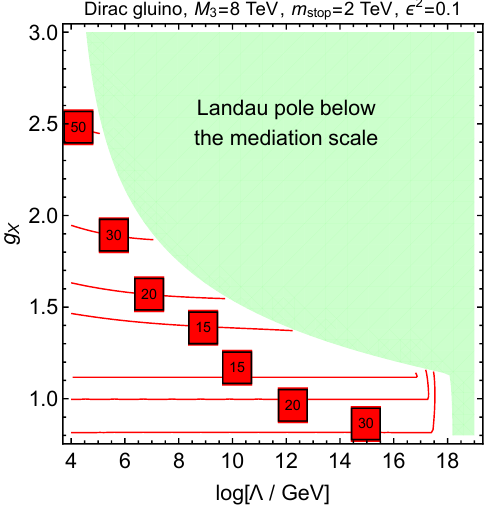
Figure 4 . The same as in the left panel of (cid:12)gure 3 but with a Dirac gluino with a soft mass M 3 = 8 TeV and M 1 = M 2 = 200